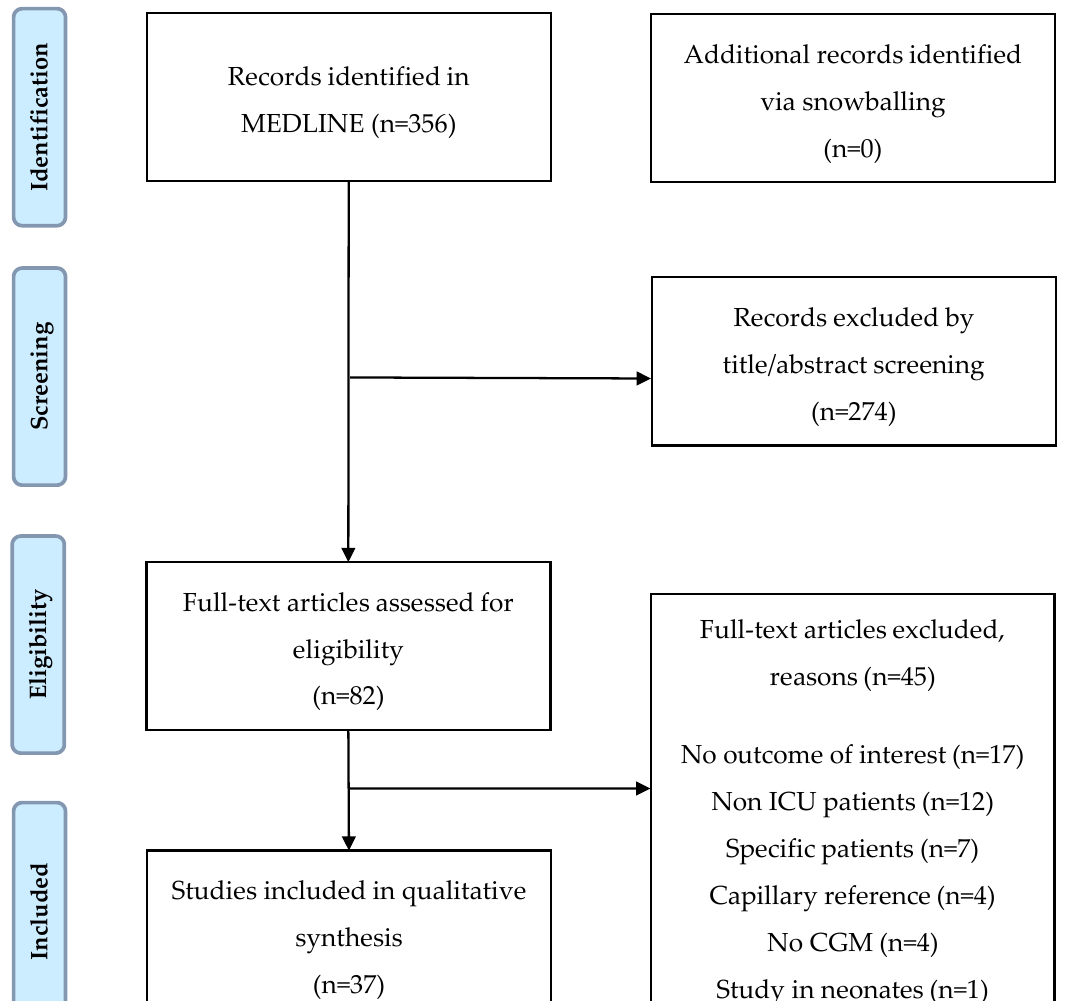
Figure 1. Flow diagram of study